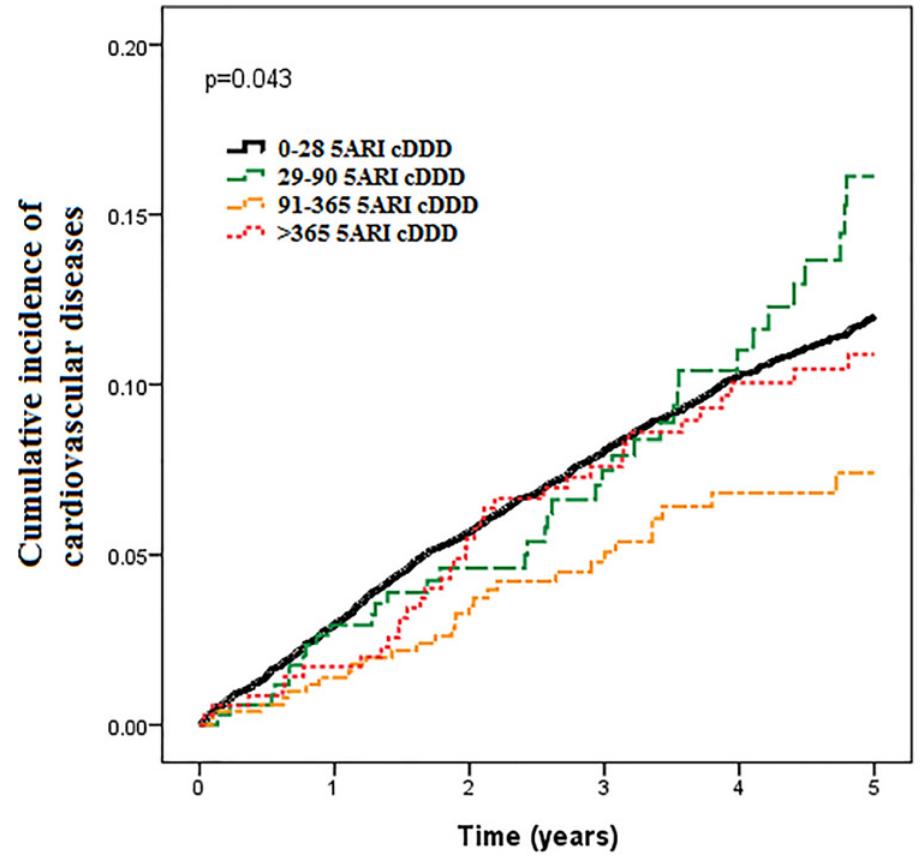
Fig 2. Kaplan-Meier failure curves of developing cardiovascular diseases in the patients receiving and not receiving 5-alpha reductase inhibitors.